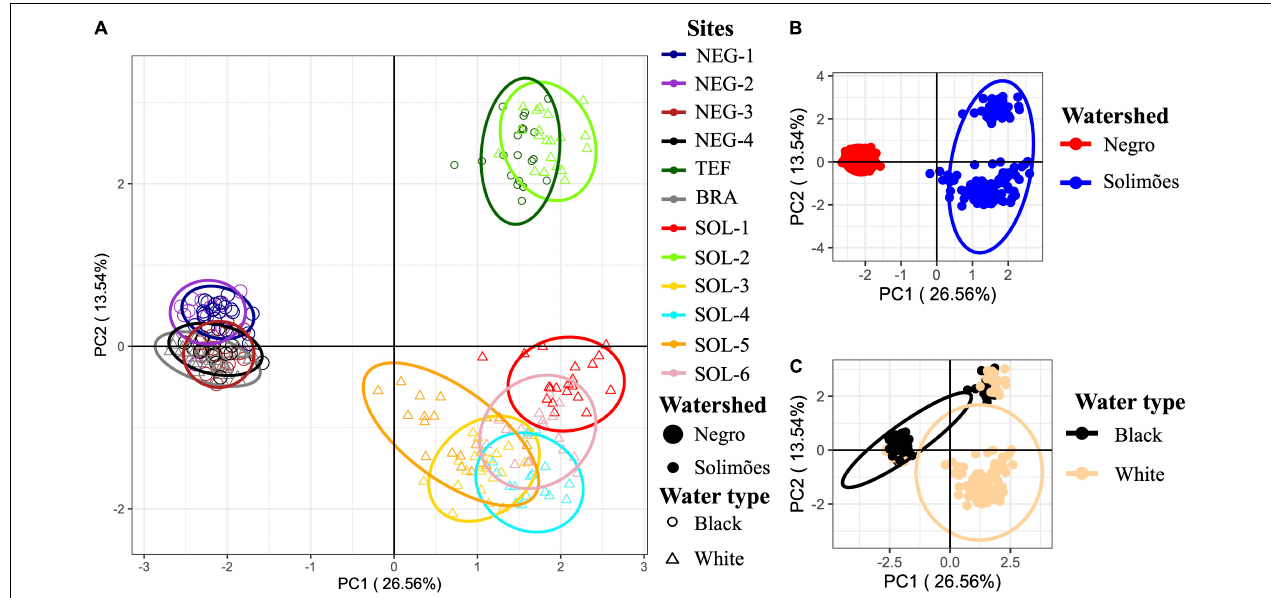
FIGURE 6 | Principal component analysis, from black and white water sites [12 sites ( n = 231)], based on the 172 SNPs associated to water type or to environmental variables associated with diverging water types. The percentage of the variance explained by the principal component’s axes are written in parentheses. Ellipses represent the 95% confidence interval of the groupings position in space. In (A) , the ellipses represent the sampling site, the point size represents the site’s watershed and the point shape the site’s water type. In (B) , samples are clustered by watershed, and, in (C) , they are clustered by water type. See in Supplementary Figure 10 PCAs with the 41,268 SNPs, which shows a very similar clustering